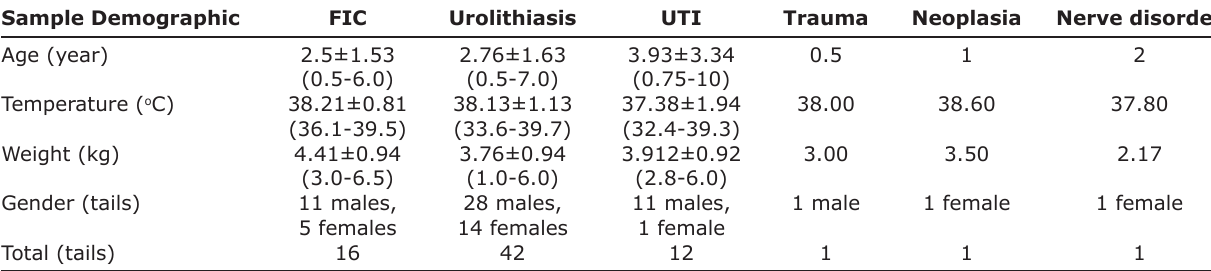
Table-3: Age, temperature, weight, and sex in each group of FLUTD